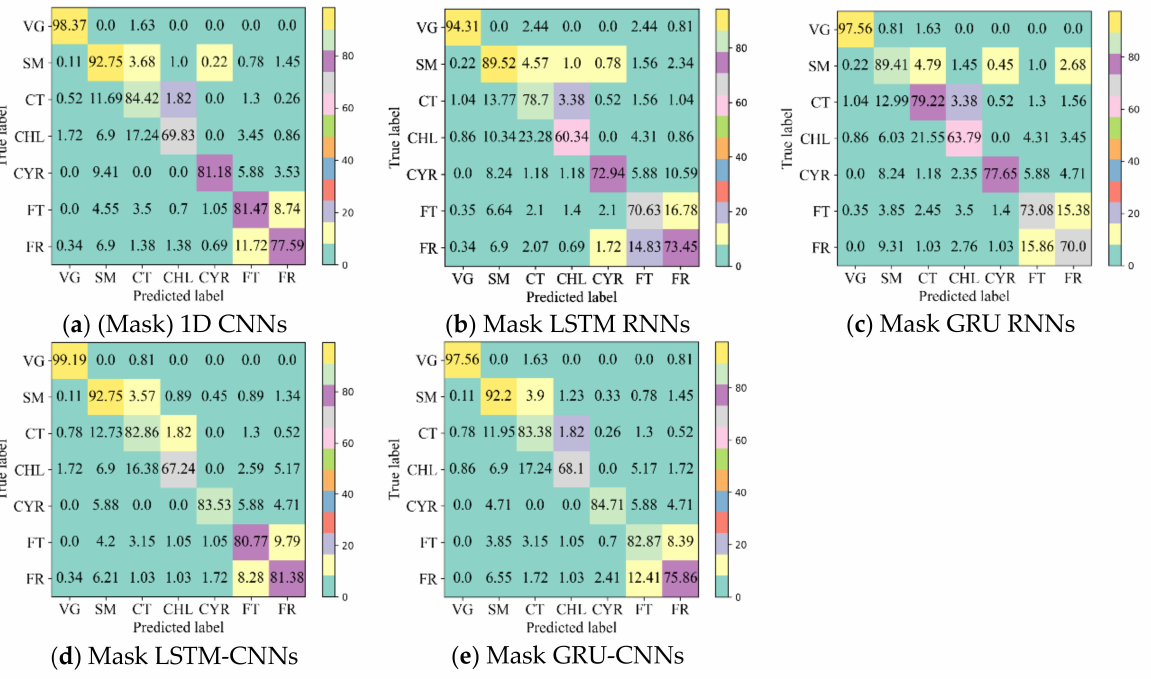
Figure 8. ( a – e ) Confusion matrices of different networks using unfilled Sentinel-2 time series data. Values in matrices are the percentage of points available in the “true label” and are the averages of the five test sets. VG, vegetable greenhouse; SM, summer maize; CT, cotton; CHL, chili; CYR, common yam rhizome; FT, fruit trees; FR,